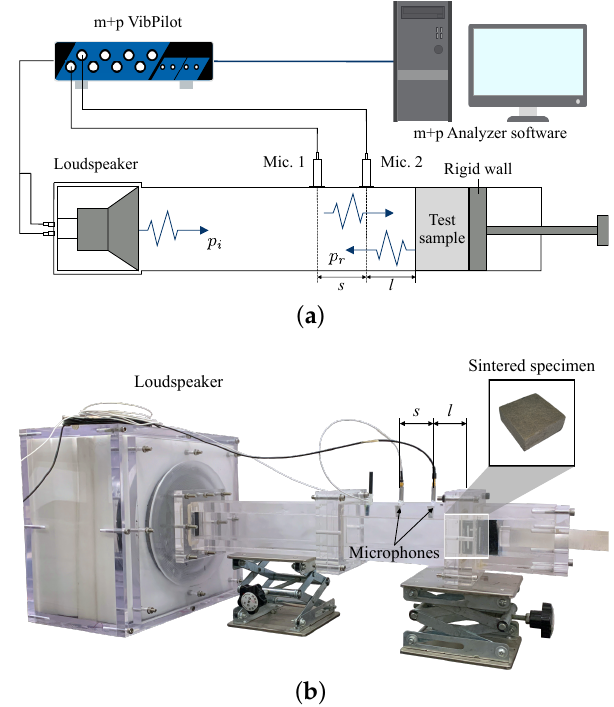
Figure 3. Acoustic measurement system used for measuring the normalised surface impedance of the prepared sintered specimens. ( a ) Schematic of the classic two-microphone impedance tube. ( b ) Realistic facility used in our